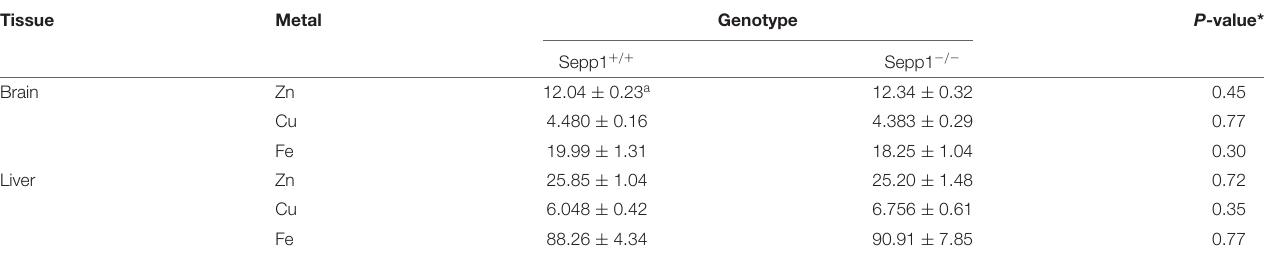
TABLE 1 | Metal content in brain and liver of Sepp1 wildtype (Sepp1 + / + ) and knockout (Sepp1 − / − ) mice at the age of 3 months (mg/kg of dry tissue, n = 20 each) measured by ICP-OES. Tissue